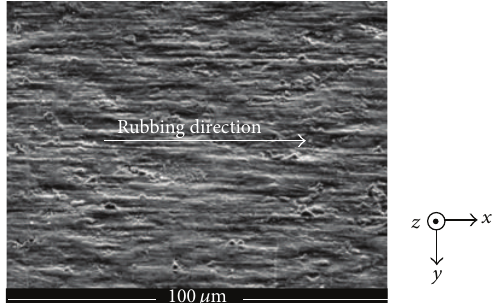
Figure 1: Scanning electron microscope image of a copper patch, coated with a 0.3-0.4 𝜇 m thick of polyimide film and mechanically rubbed, along the 𝑥 -axis